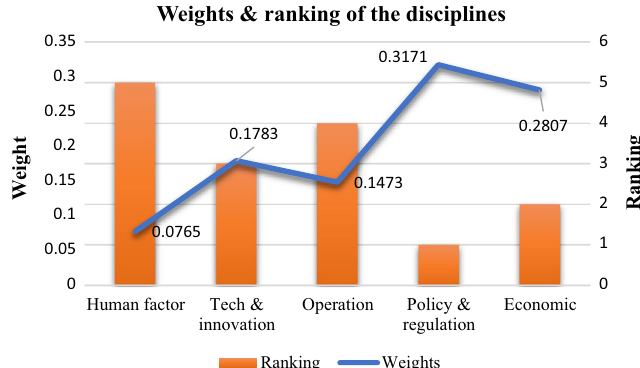
Fig. 8 Weights and ranking of the disciplines